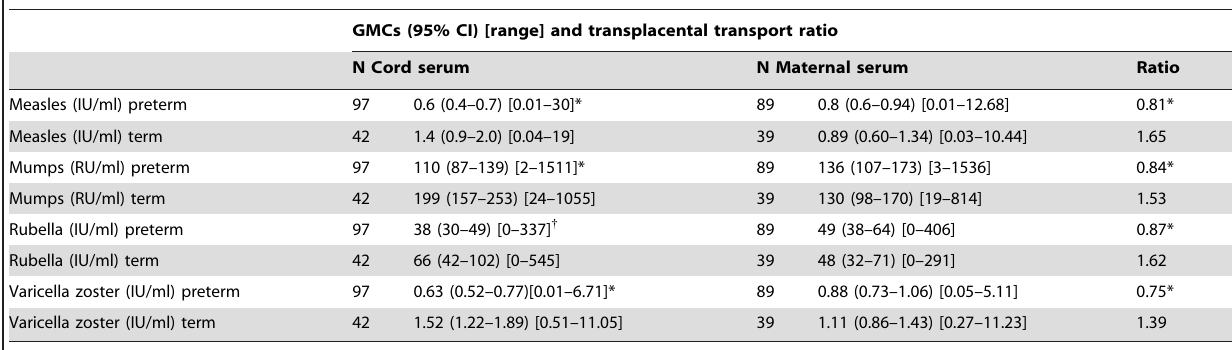
Table 1. Number of samples tested, geometric mean concentration (GMCs) and transplacental transport ratios of antibodies to measles, mumps, rubella and varicella zoster in preterm and term infants.